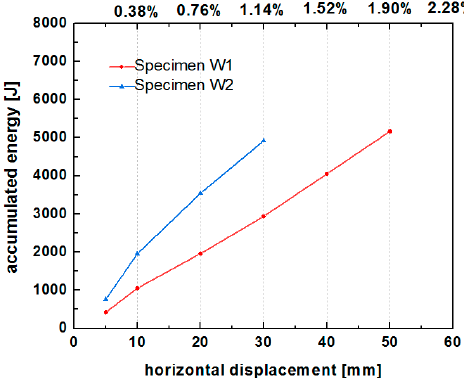
Figure 19. Cumulative energy of specimens W1 and W2.